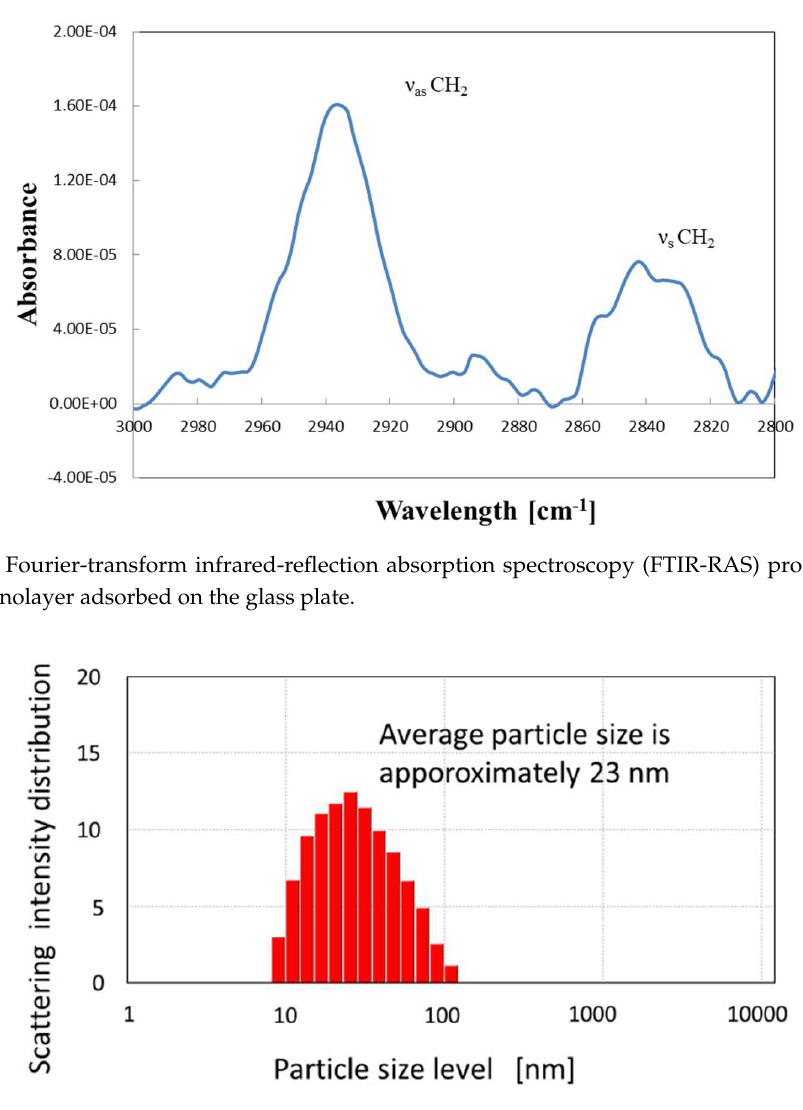
Figure 8. Particle-size distribution of the Pt nanoparticles.